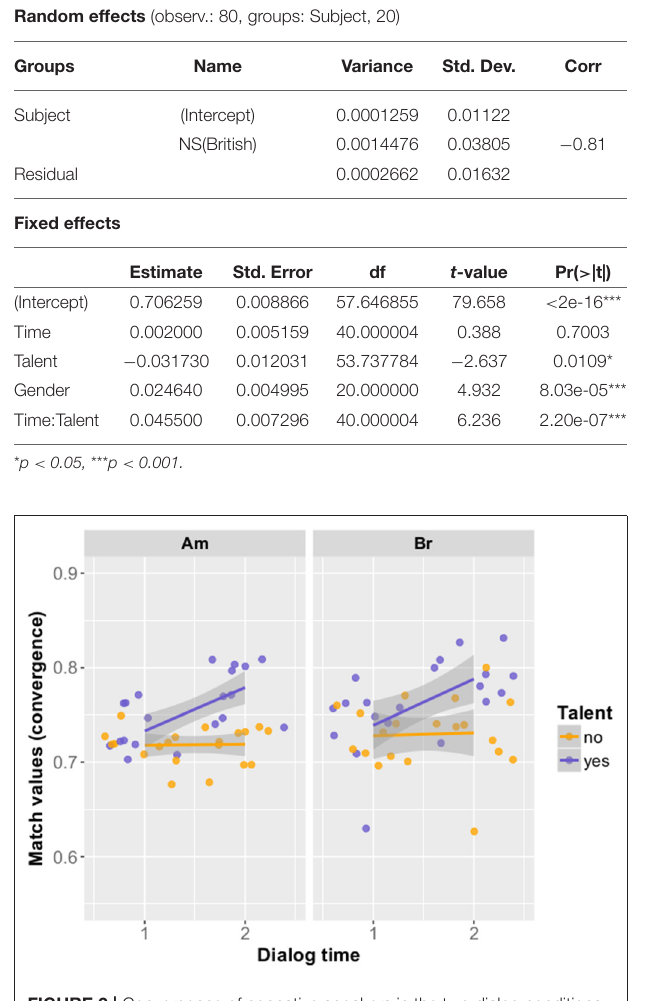
FIGURE 2 | Convergence of nonnative speakers in the two dialog conditions (British and American) with talent color-coded. Displayed is the difference in match values (Y axis) between an early and a late point in the dialog (Time on X axis), with groups divided according to phonetic